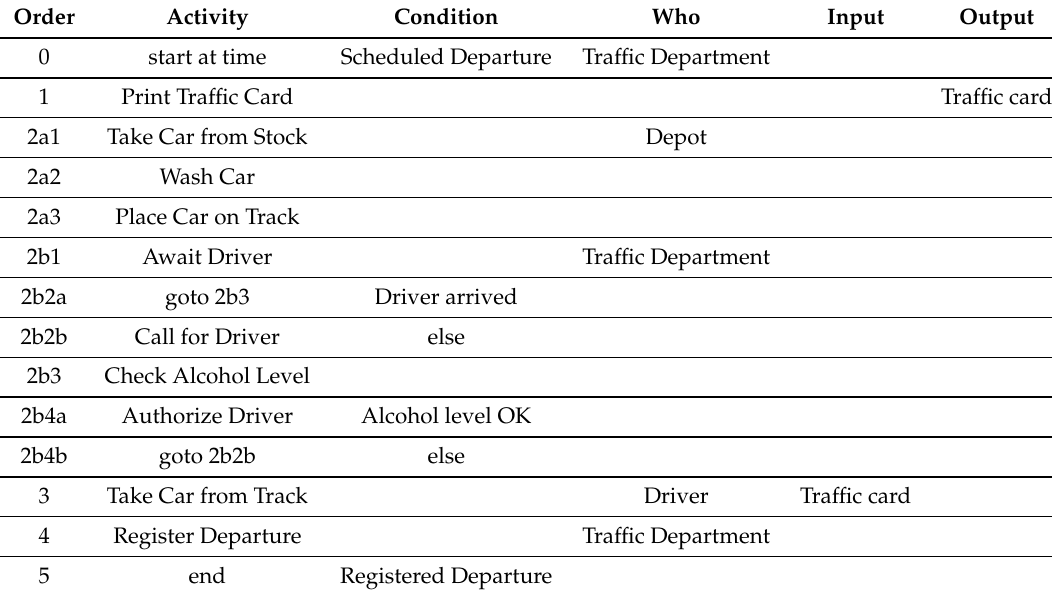
Figure 5. An example of an equivalent model to the spreadsheet-based process description presented in Table 18. Table 18. Tramway Dispatching.